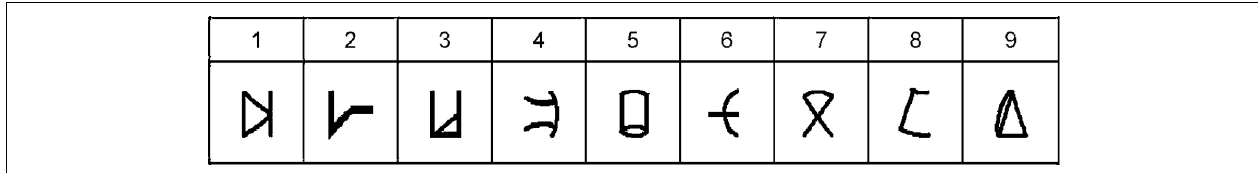
FIGURE 1 | Artificial digits. Symbols used as stimuli during the learning phase and the numerical Stroop task and their equivalent as everyday digits — adapted from Tzelgov et al. (2000). Reprinted from Cohen Kadosh et al. (2010), with permission from Elsevier.